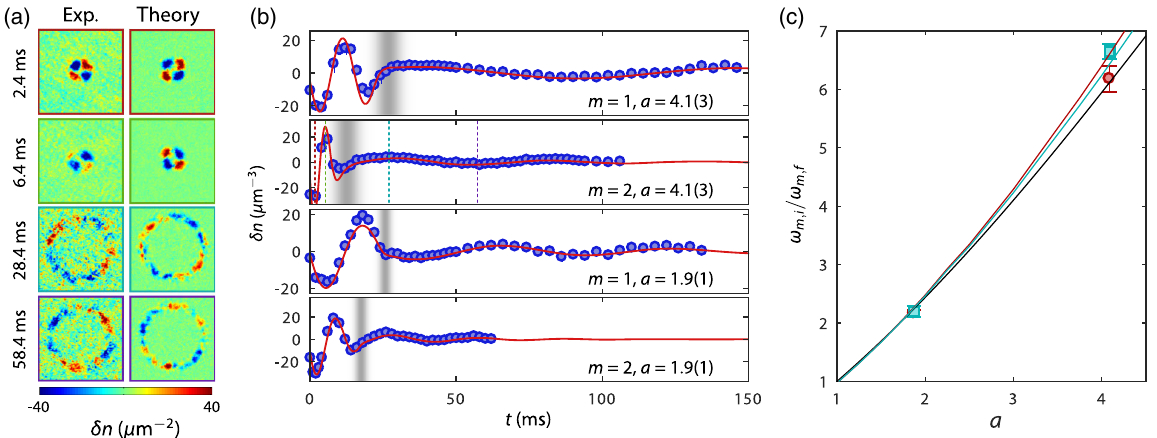
FIG. 2. Redshift of long-wave excitations. (a) Atomic density difference δ n at various times for both experiment and simulation for a mode number m ¼ 2 and scale factor a ¼ 4 . 1 . The density scale of images after expansion is multiplied by 10. (b) Phonon amplitude vs time for various a and m . The grey bands indicate the time during which the BEC is inflated; their intensity denotes the expansion velocity relative to that expansion ’ s maximum. Vertical dashed lines in the m ¼ 2 , a ¼ 4 . 1 panel indicate the times shown in (a). (c) Ratio of initial to final frequency vs scale factor a . Red circles indicate m ¼ 1 modes; cyan squares, m ¼ 2 . The solid black curve is the a 9 = 7 expectation, and the colored curves (with mode numbers matching points) are the result of full Bogoliubov